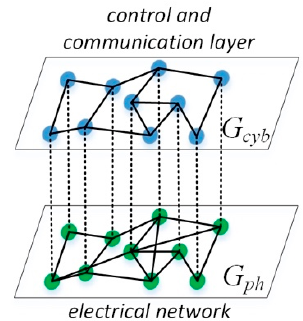
Figure 3. Multi-layered architecture for electrical network and supervisory control analysis.